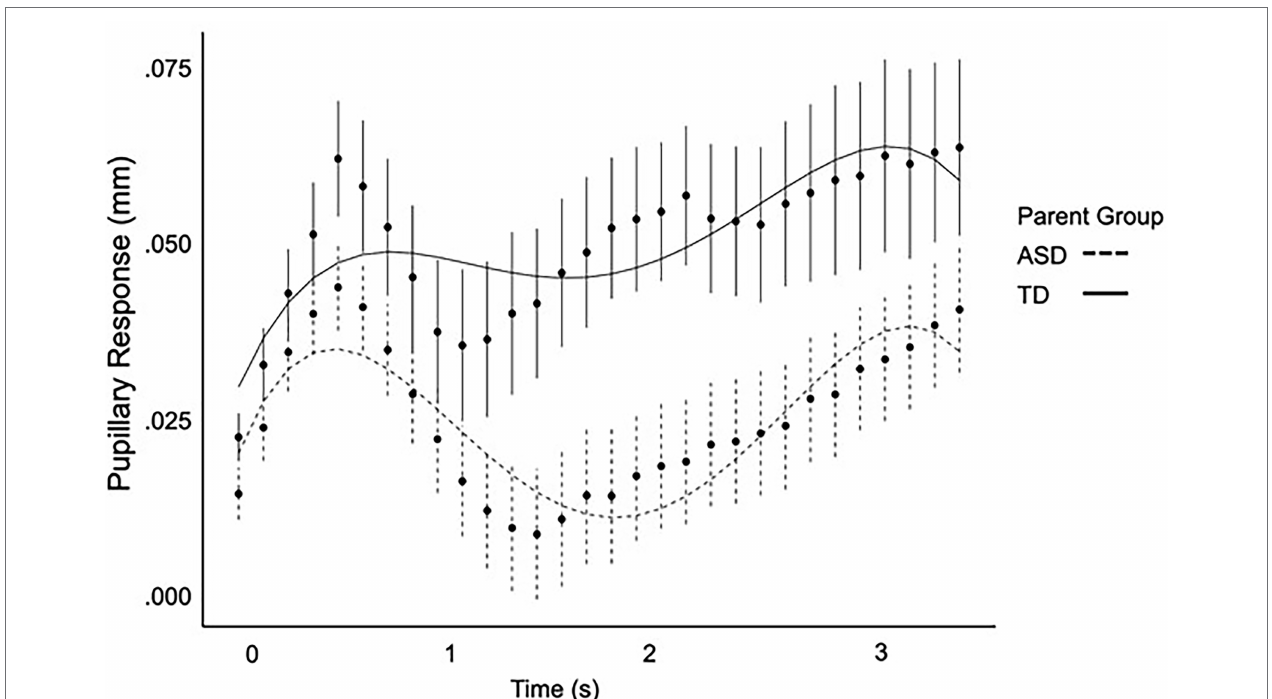
FIGURE 1 | Pupil response over time as modeled by a fourth-order regression equation for ASD parents and parent